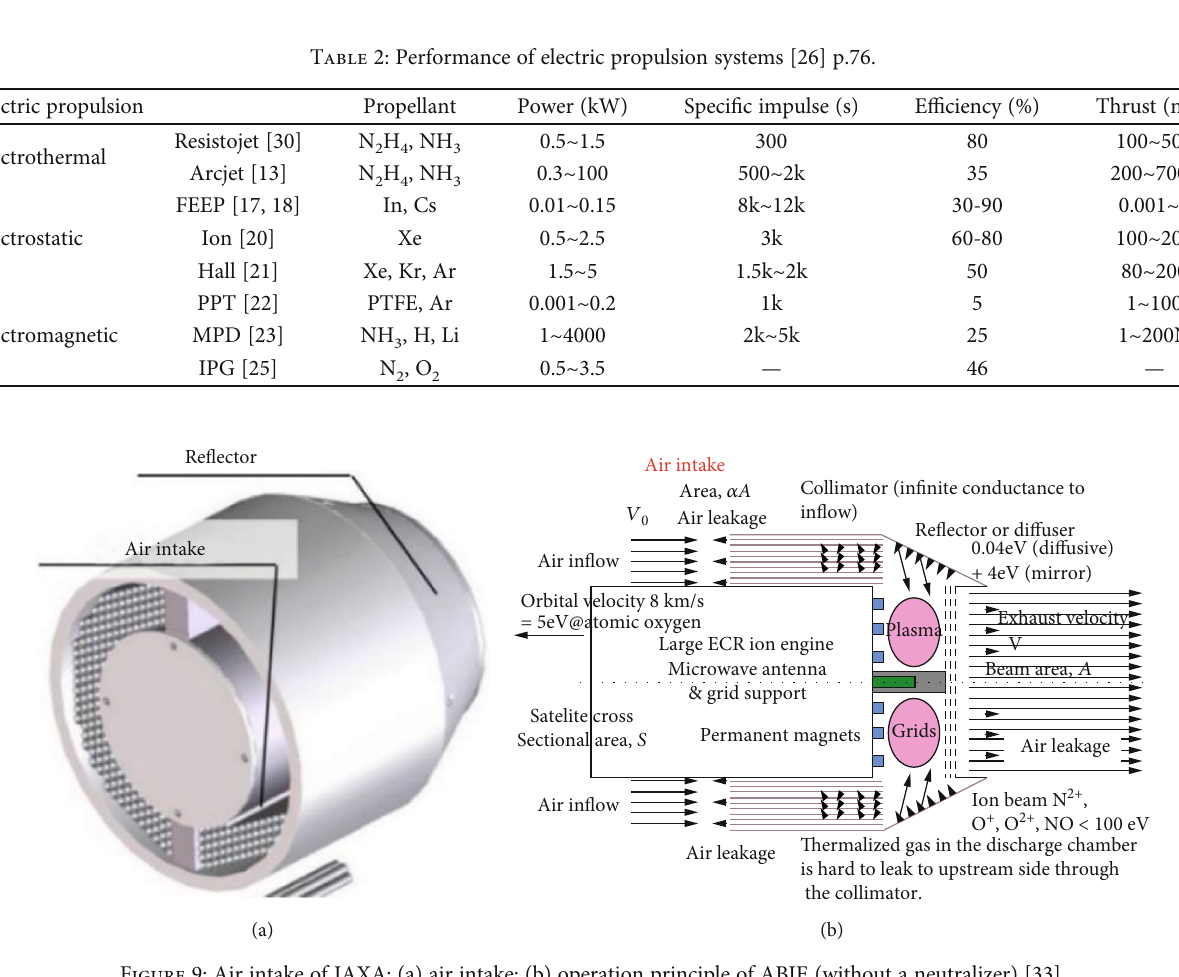
Figure 9: Air intake of JAXA: (a) air intake; (b) operation principle of ABIE (without a neutralizer)